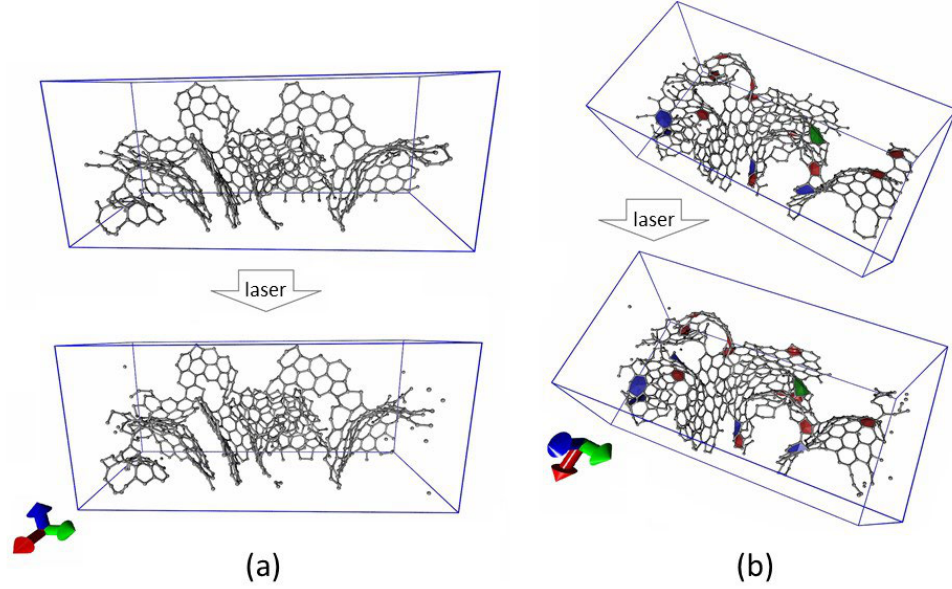
Figure 4. Atomistic structure of the quasi-2D layer surface: ( a ) Before and ( b ) After laser exposure. Thus, pulsed laser exposure can contribute to the formation of a surface from graphene flakes and from hybrids based on graphene and SWCNT, which is accompanied by partial destruction of the edge fragments of